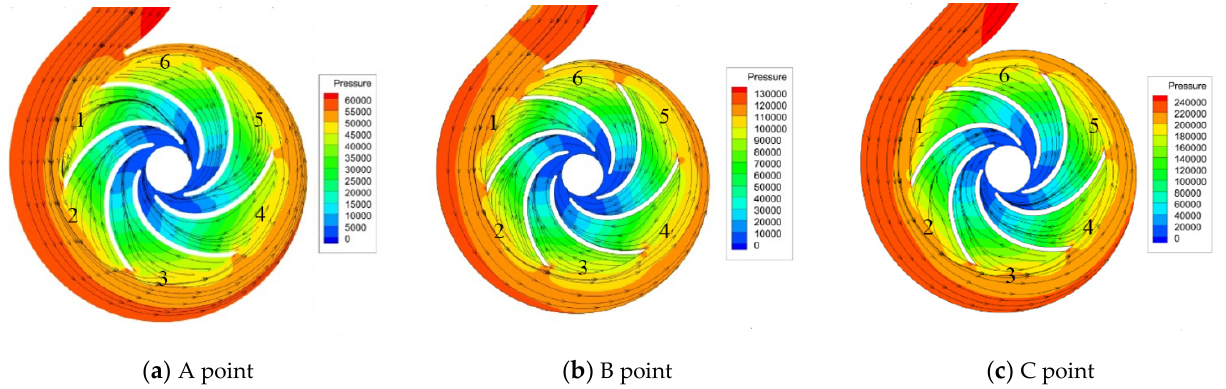
Figure 8. Pressure and streamlines of ISO surface.